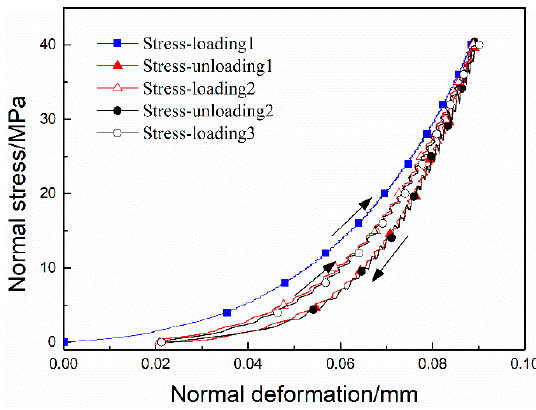
Figure 5. The curve of normal stress-normal deformation of jointed sample multiple under multicycle stress-loading and -unloading condition.